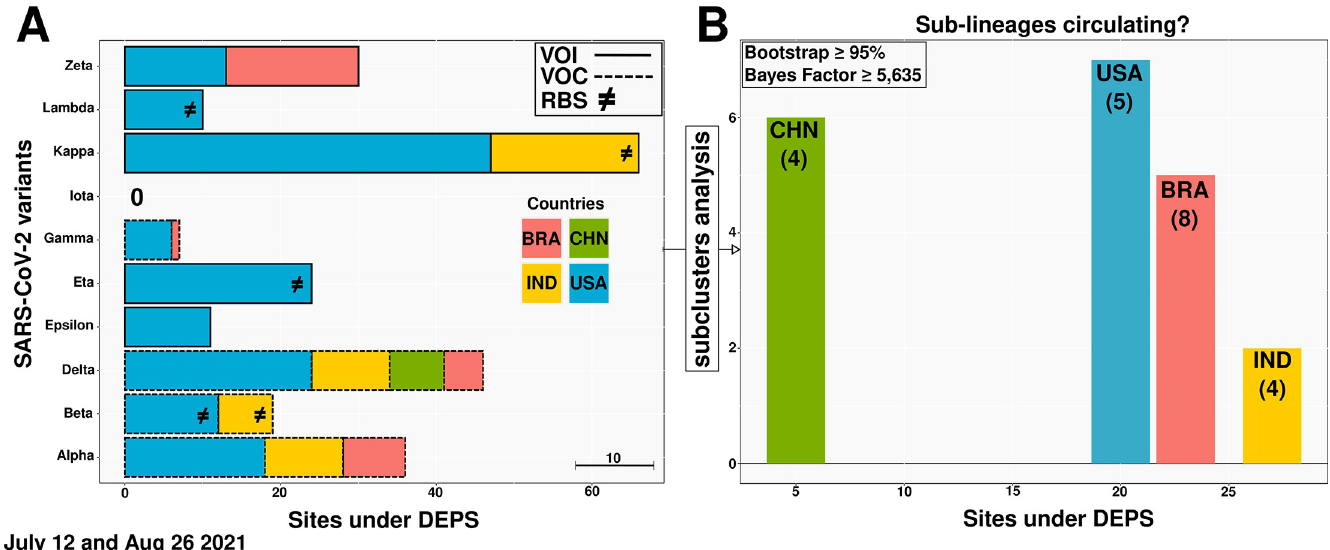
Fig 3. Transmission clustering and sub-clustering analyses on SARS-CoV-2 Variants of Concern (VOC) and Variants of Interest (VOI) sequences. ( A ) Directionally evolving sites in the VOC (dashed line) and VOI (unbroken line) sampled from the model-based phylogenetic Maximum Likelihood (ML) method and ( B ) the number of sub-clusters inferred in strains circulating in Brazil, China, India and the USA. Each color represents a particular country. RBS stands for recombination breakpoints signal ( 6¼ ) and the scale bar shows the proportion of ten sites under DEPS (A). The numbers in parentheses indicate Spike-encoding protein sites under convergent evolution (B). Obs.: (1) In panel A, the majority of these sites, distributed across the genome, are also under convergent evolution and (2) the data extracted from the India’s SARS-CoV-2 Eta dataset did not show sites under DEPS, but did exhibit signals of recombination (see Data Availability).